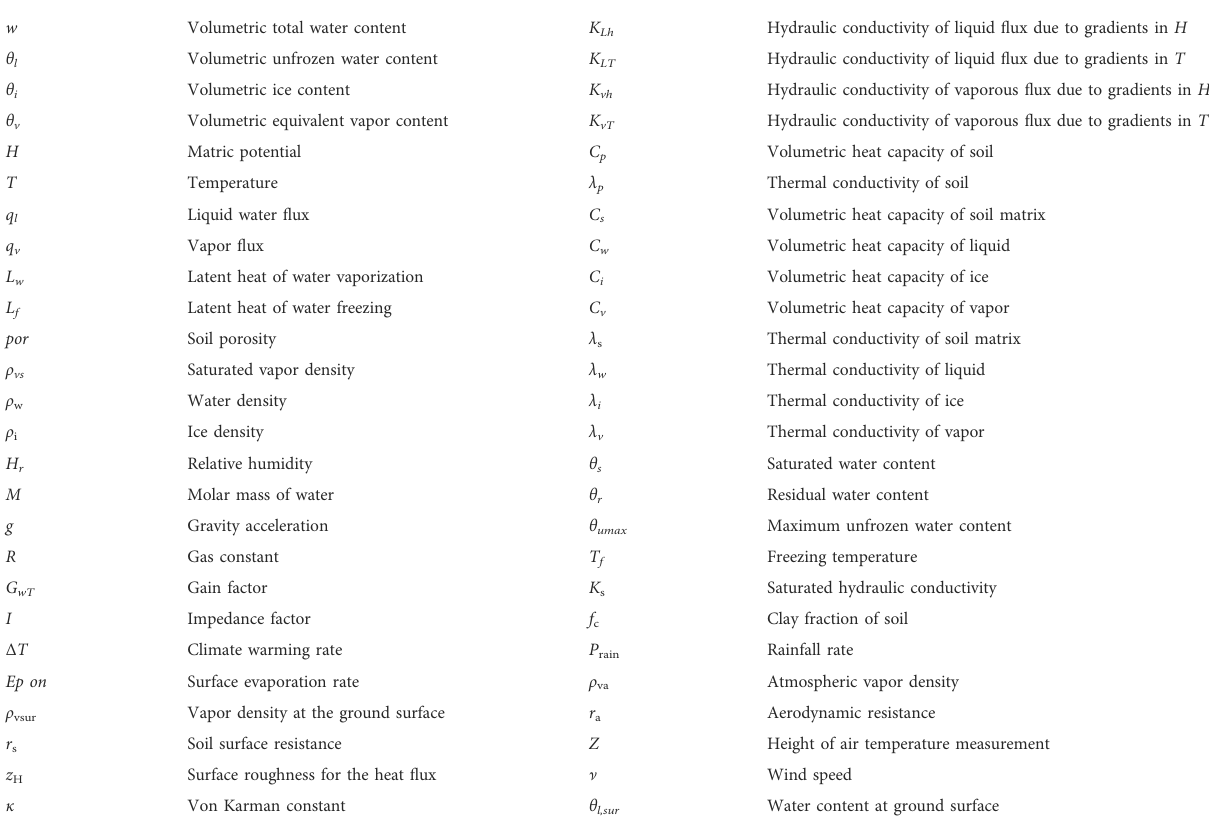
TABLE 1 List of symbols.